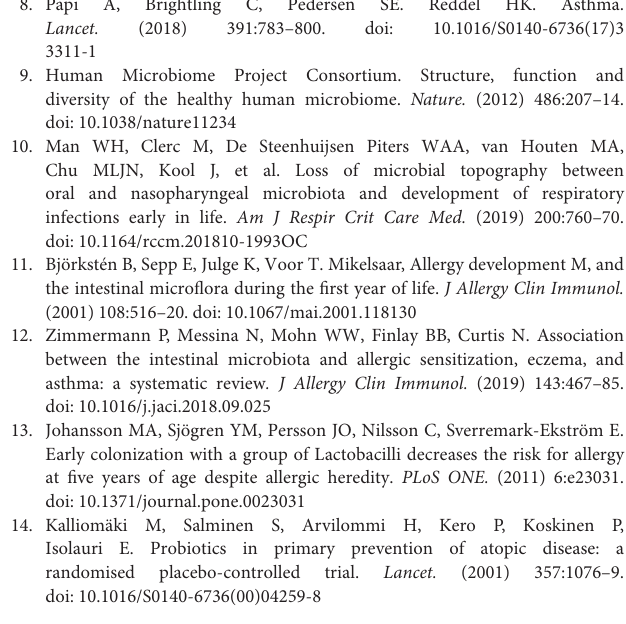
Supplementary Figure 1 | Heatmap analysis of class abundance clustering in patients with AR. P < 0.05. The heatmap shows the rank based on abundance. Each column represents one group, while each row in the heatmap represents one class. The red to blue color bar indicates the relative abundance. AR, allergic rhinitis. Supplementary Figure 2 | Heatmap analysis of order abundance clustering in patients with AR. P < 0.05. The heatmap shows the rank based on abundance. Each column represents one group, while each row in the heatmap represents one order. The red to blue color bar indicates the relative abundance. AR, allergic rhinitis. Supplementary Figure 3 | Heatmap analysis of family abundance clustering in patients with AR. P < 0.05. The heatmap shows the rank based on abundance. Each column represents one group, while each row in the heatmap represents one family. The red to blue color bar indicates the relative abundance. AR, allergic rhinitis. Supplementary Figure 4 | Heatmap analysis of feature abundance clustering in patients with AR. P < 0.05. The heatmap shows the rank based on abundance. Each column represents one group, while each row in the heatmap represents one feature. The red to blue color bar indicates the relative abundance. AR, allergic